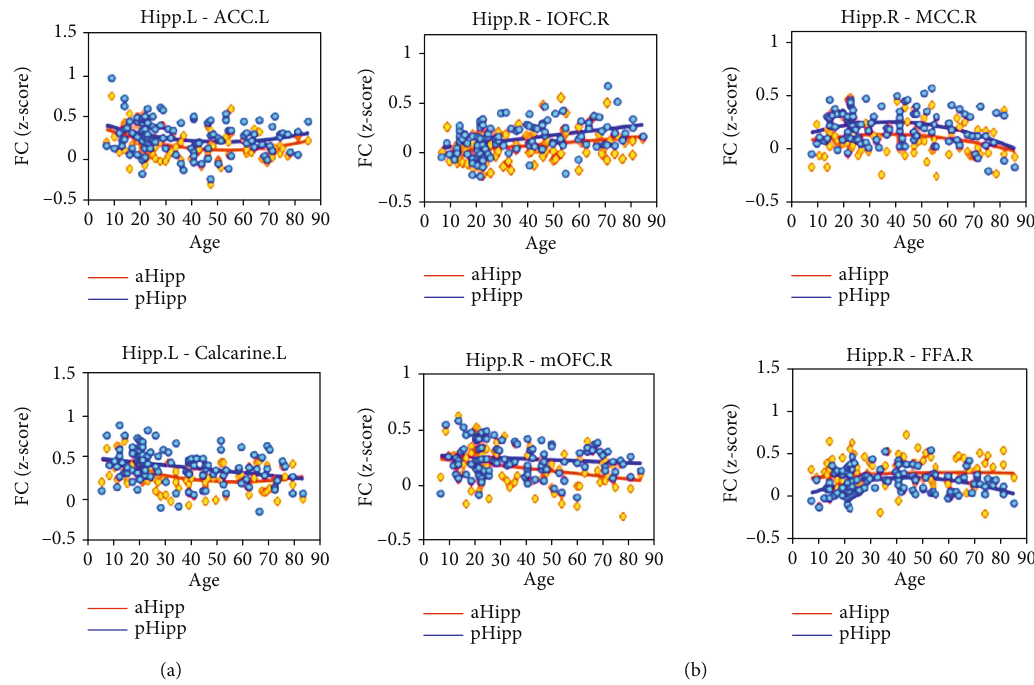
Figure 3: Trends of hippocampal functional connectivity with age. (a) The FC results of GLM in the left hemisphere. The U-shaped trajectories of FC included aHipp.L-ACC.L, pHipp.L-ACC.L, and aHipp.L-Calcarine.L. The linear downward trajectory of FC included pHipp.L-Calcarine.L. (b) The FC results of GLM in the right hemisphere. The inverted U-shaped trajectories of FC included pHipp.R- MCC.R and pHipp.R-FFA.R. The linear upward trajectories of FC included aHipp.R-lOFC.R and pHipp.R-lOFC.R. The linear downward trajectory of FC included pHipp.R-mOFC.R. Orange plots represented the aHipp and blue plots the pHipp ( “ .L ” : “ left hemisphere ” ; “ .R ” : “ right hemisphere ”